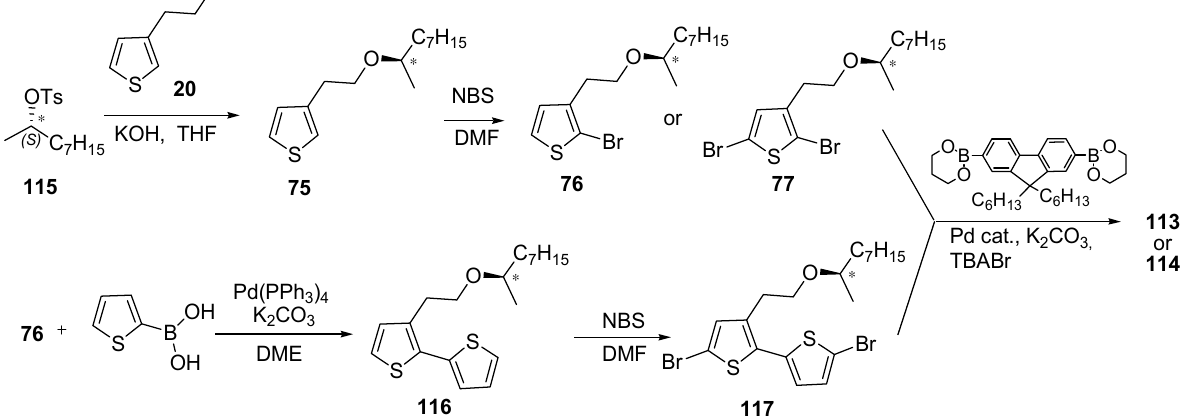
Figure 1. Structures of copolymers with the chiral side chains. The monomers for 113 and 114 , 2,5-dibromo–3-{2-[( S )-(+)-1-methyloctyloxy]ethyl}thiophene 77 and 2,5-dibromo-3-{2-[( S )-(+)-1-methyloctyloxy]ethyl}2,2 ′ -bithiophene 117, respectively, were synthesized as shown in Scheme 34 [78,96].